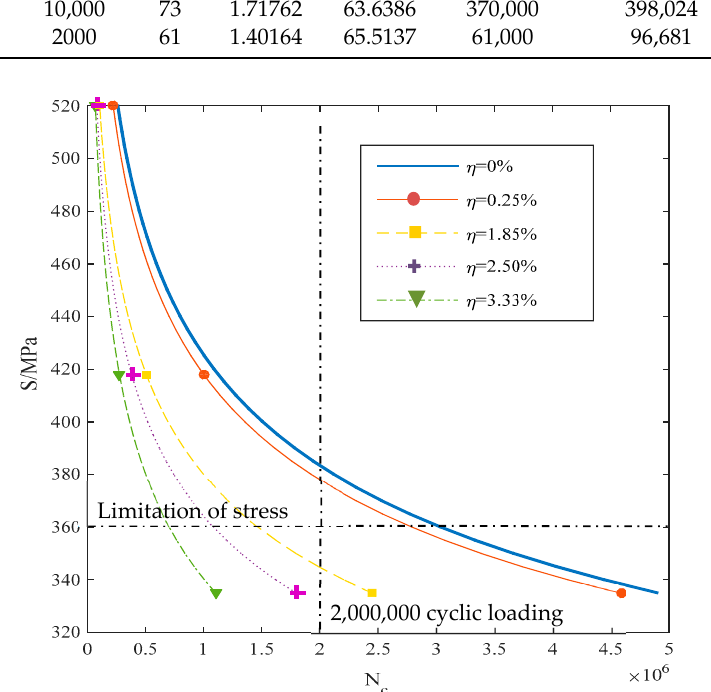
ff erent degrees of